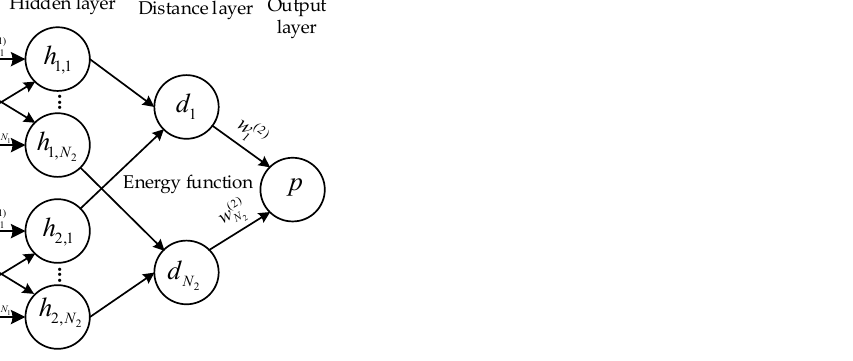
Figure 1. The framework of Siamese neural network. A pair of parallel networks extract features separately, and an energy function connects them to measure a certain relationship between two features.